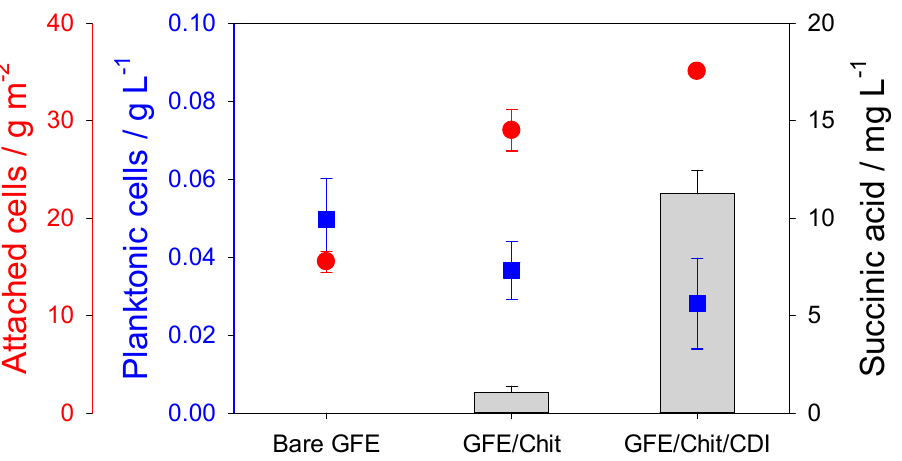
Figure 6. Final biomass (attached and planktonic cells) and succinic acid production from microbial electrosynthesis reaction of R. sphaeroides for 14 d under − 0.6 V (vs. Ag/AgCl) and 5% CO 2 . The weight of attached cells (g m − 2 ) was normalized to the area of the graphite felt electrode. Bar chart, succinic acid (mgL − 1 ). Square symbol (blue), planktonic cells (gL − 1 ). Circle symbol (red), attached cells (g m − 2 ).